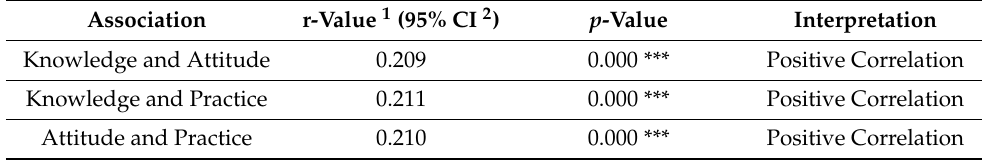
Table 5. Correlation in KAP domain among university students of Dhaka city, Bangladesh.